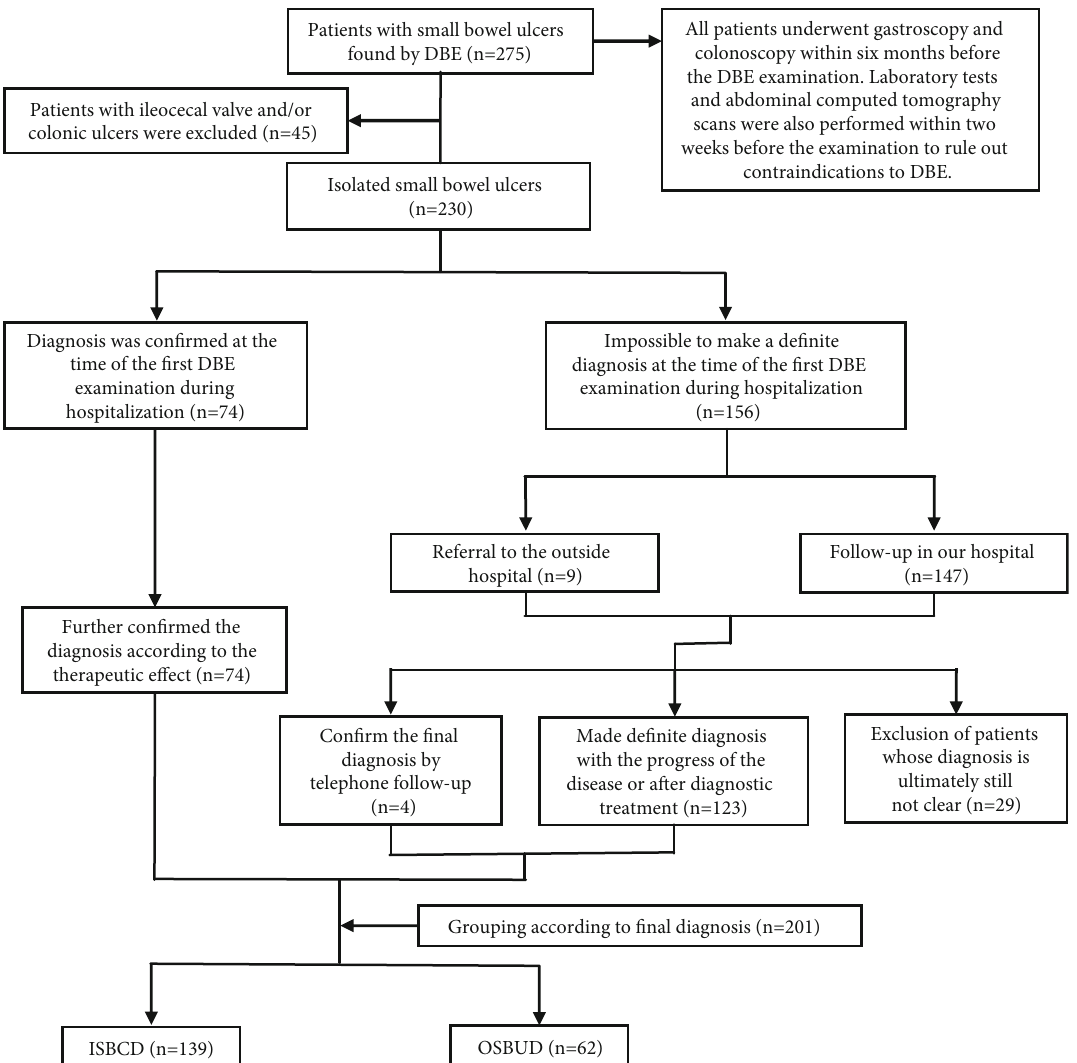
Figure 1: Diagnostic and grouping process. ISBCD: isolated small bowel Crohn ’ s disease; OSBUD: other small bowel ulcerative